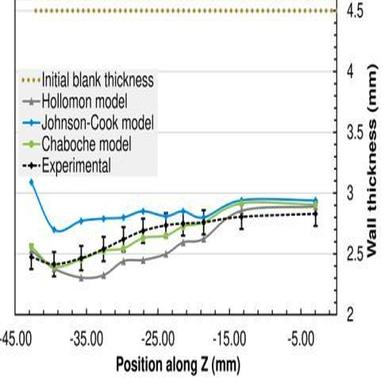
Wall thickness distributions predicted by the considered models compared with the experimental data.